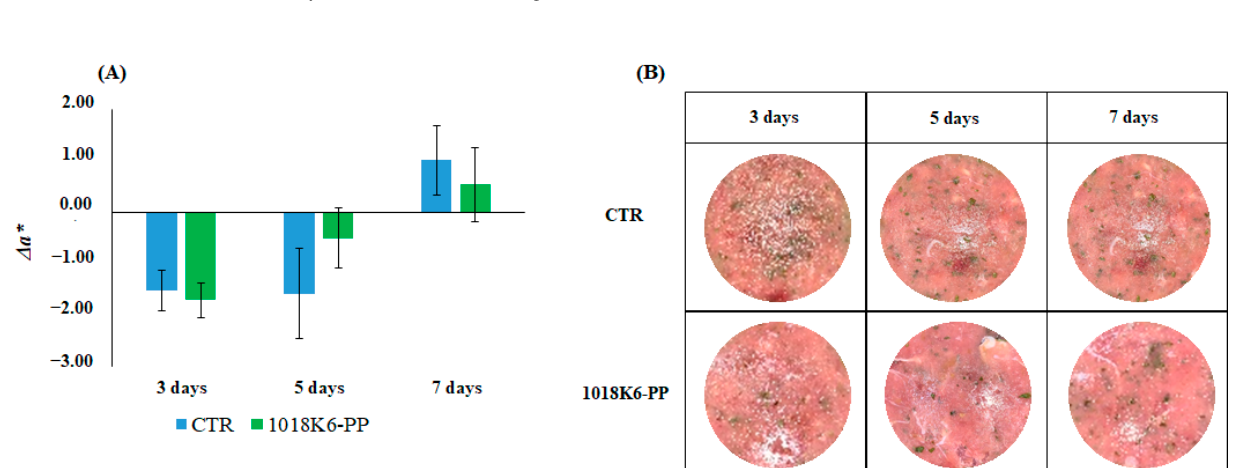
Figure 8. Effects of 1018K6-PP slides on the chemical quality of Sarda sarda burgers. Changes in TVB- N ( A ), TMA-N ( B ) and TBARS ( C ) of Sarda sarda burgers packaged in active 1018K6-PP films during storage at 4 °C. CTR (blue lines)—PP films without 1018K6; 1018K6-PP (green lines)—PP films func- tionalized with 1018K6. Results are means of three independent experiments and error bars repre- sent the standard error (sem). Different letters at each sampling time are used for significantly dif- ferent samples, according to Tukey test (uppercase letters: p < 0.01; lowercase letters: p < 0.05).